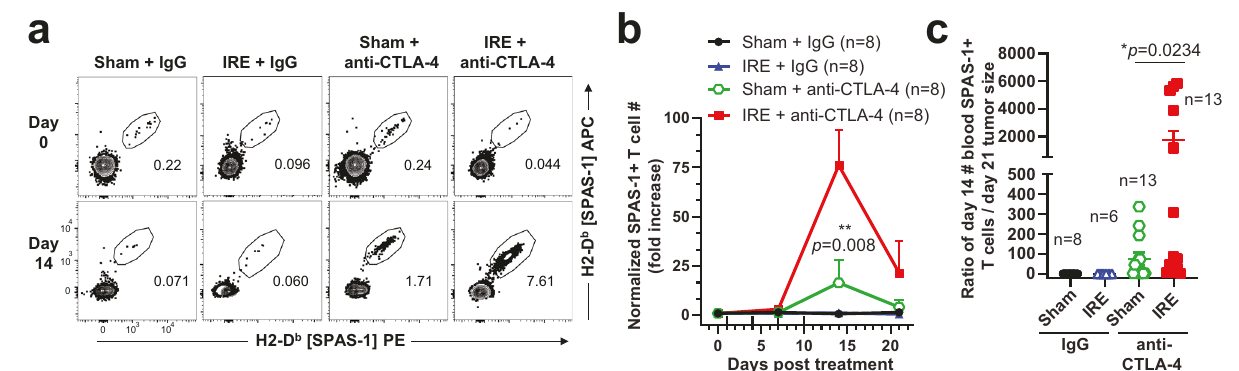
Fig. 5 SPAS-1 + T cells are increased in the blood following combination therapy and predict tumor outcome. Mice bearing TRAMP-C2 tumors were treated as in Fig. 4. a Representative SPAS-1 tetramer staining of CD8 + T cells in peripheral blood at days 0 and 14 following the indicated treatment. b The absolute number of SPAS-1 + T cells per 100 µ l of blood was calculated at days 7, 14, and 21 following treatment and normalized to the baseline in each mouse at day 0. c Ratio of the number of SPAS-1 + T cells per 100 µ l of the blood of each mouse at day 14 over the endpoint tumor size at day 21. Data in ( b ) represent blood tested in n = 8 individual mice/group. c n = 6 – 13 individual mice/group, with exact n shown for each group. Data pooled from four independent experiments. Bars represent mean ± S.E.M. Unpaired two-tailed Mann – Whitney test was performed; * p < 0.05, ** p < 0.01 Source data are provided as a Source Data